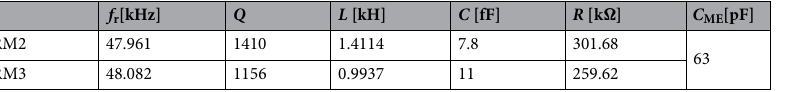
Table 1. Results of the mBVD fit. Equivalent circuit parameters, resonance frequencies f r and quality factors Q of the two higher resonance modes RM2 and RM3 at zero bias field.